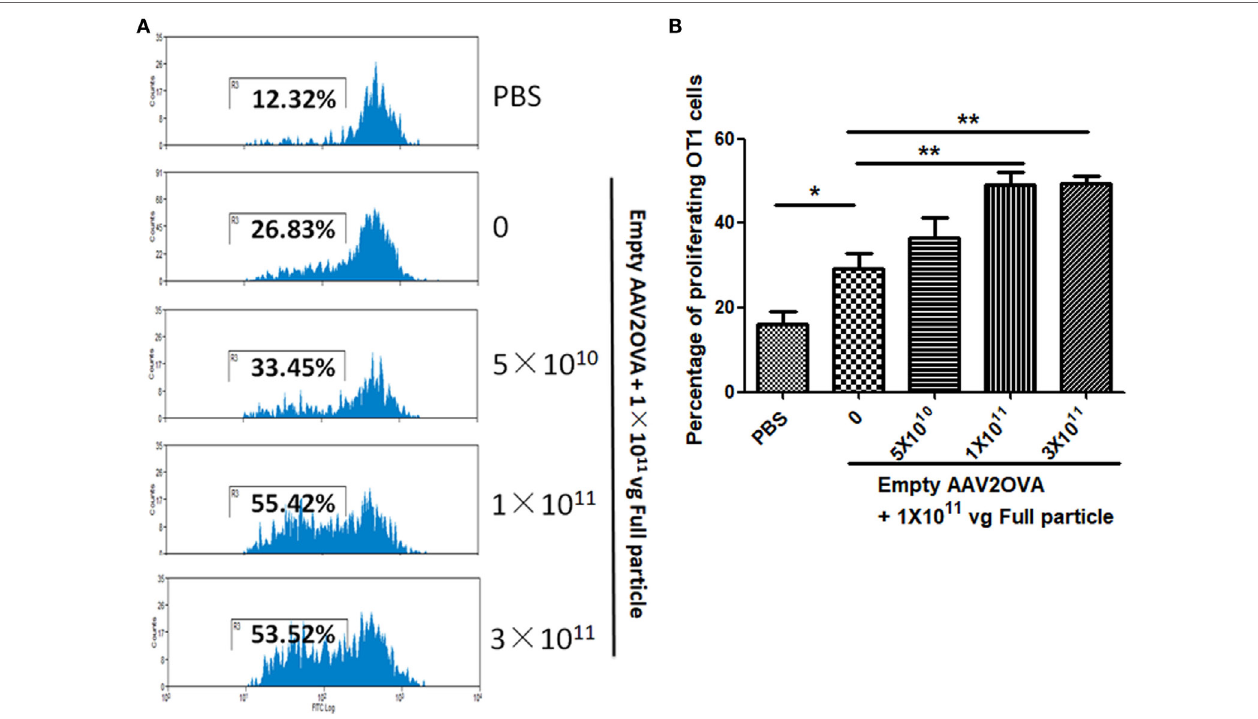
FigUre 6 | Contamination of empty virions in adeno-associated virus (AAV) preparation increases capsid antigen presentation. Different amounts of AAV2OVA empty virions were mixed with 1 × 10 11 particles of AAV2OVA/alpha-1-antitrypsin (AAT) vectors and then administered into C57BL mice via retro-orbital injection. At day 3 post AAV injection, OT-1 spleen cells were transfused. Ten days later, mice were killed, and spleen cells were collected for OT-1 cell proliferation assay. (a) Representative flow cytometric histograms. (B) Average T cell proliferation and SD from five